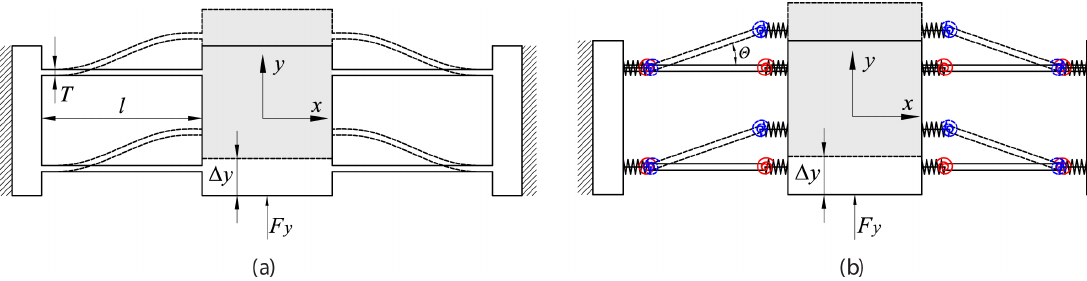
Figure 8. (a) Compound compliant parallelogram mechanism. (b) MPRB model